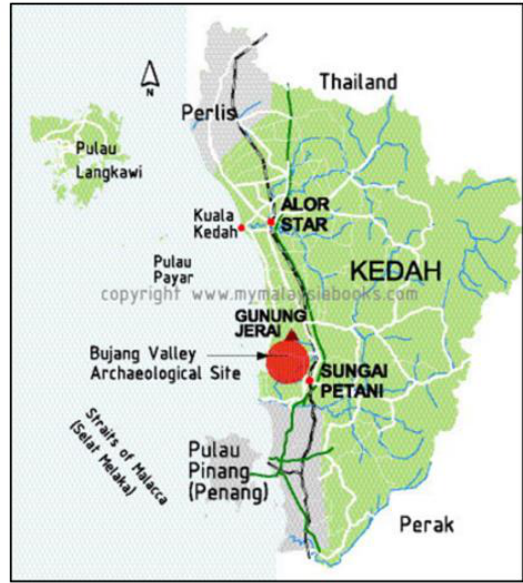
Figure 2: Map of Kedah and the location of the Bujang Valley Archaeological Site [12]